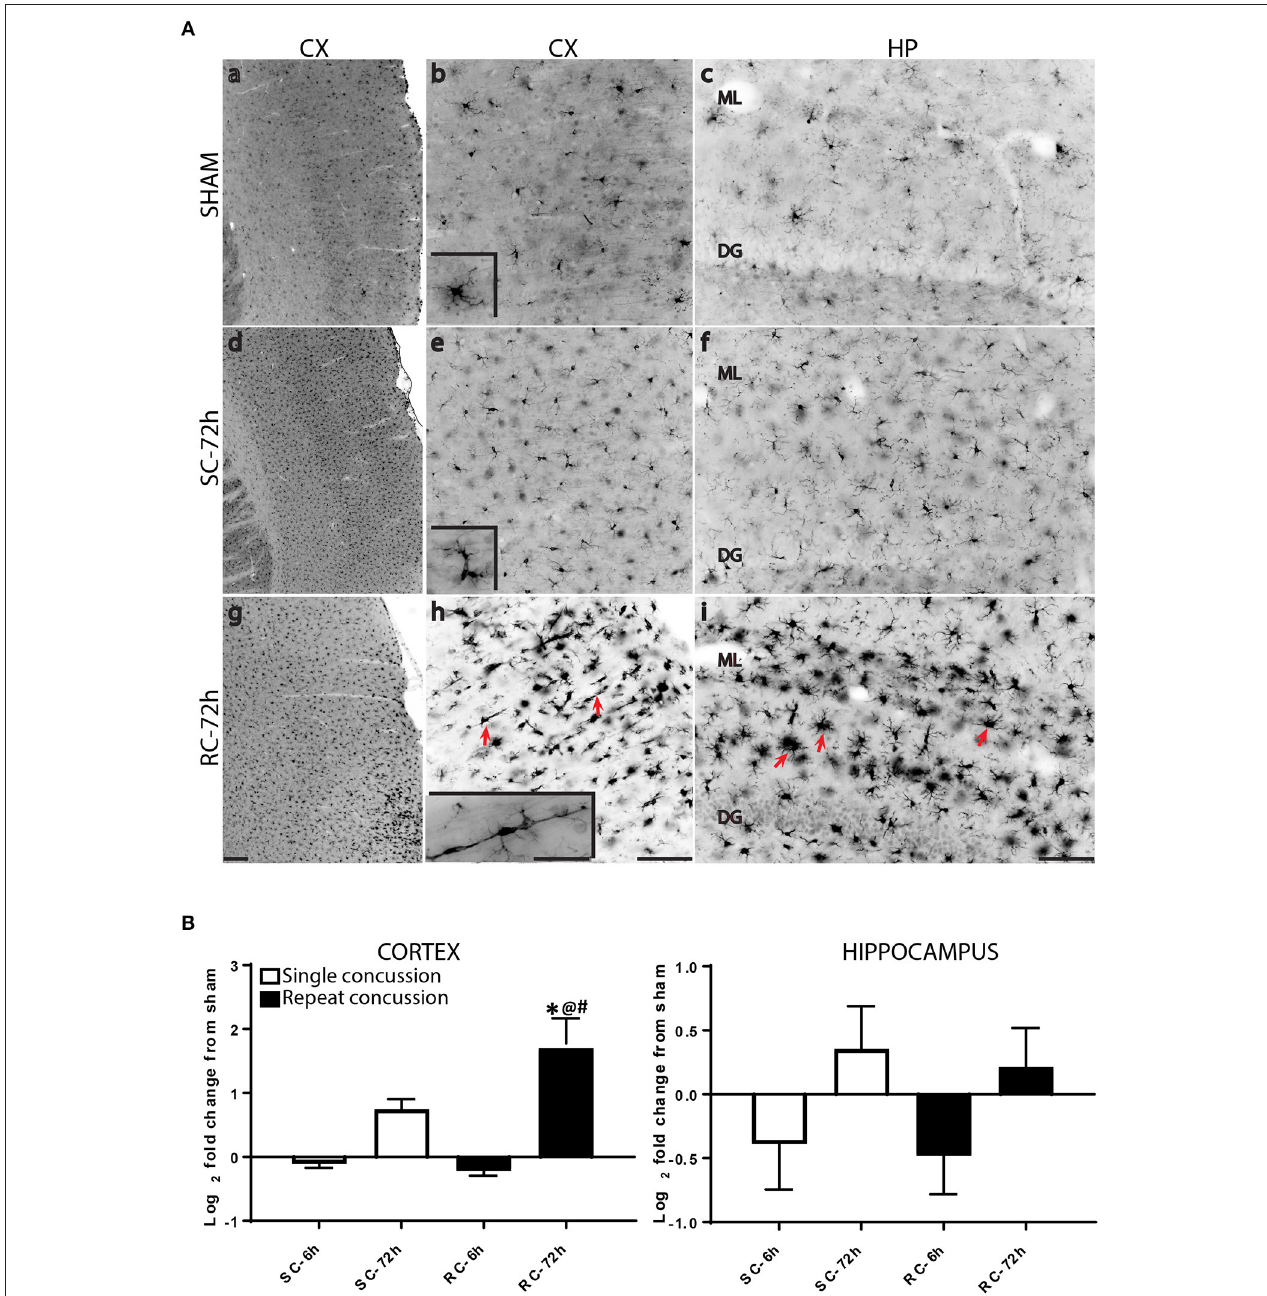
FIGURE 2 | Changes in microglial morphology and Iba-1 expression following concussive injury. (A) Iba-1 immunohistochemical staining in the ipsilateral cortex and hippocampus at 72h following either single or repeated concussion. Resting, ramified microglia was observed in the sham cortex and hippocampus (top panel, a–c ). Following single hit, microglia showed activated morphology with retracted processes (middle panel, d–f ). Repeated hits showed elongated microglia ( g,h , arrows) in the cortex and bushy, hypertrophied microglia ( i , arrows) in the hippocampus. (B) Quantification of Iba-1 gene expression in the cortex and hippocampus. One-way ANOVA with Tukey’s post-hoc test. * p < 0.05 compared to single hit 6h. @ p < 0.05 compared to repeated hit 6h. # p < 0.05 compared to Single hit 72h. SC: single concussion, RC: repeated concussion, CX: cortex, HP: hippocampus, ML: molecular layer, DG: dentate gyrus. Scale bar in g (for left panel) = 200 µ m, in h (middle panel) and I (left panel) = 100 µ m and inset (for insets in middle panel) in h = 50 µ m.